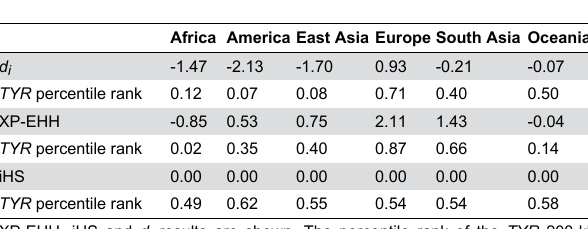
Table 2. Whole-genome selection scan results of six studied populations.